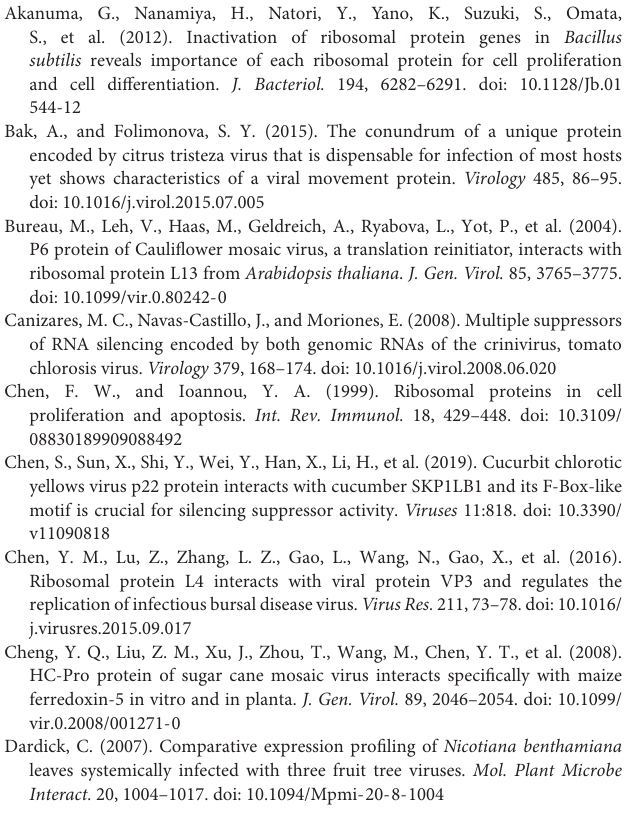
Supplementary Figure 1 | Alignment of amino acid sequences of CsRPS21 from different cucurbit plants. Supplementary Figure 2 | YFP fluorescence was not detected in the combination of P22-nYFP + cYFP and nYFP + CsRPS21-cYFP. Bar scale represents 20 µ m. Supplementary Figure 3 | (A) Colocalization of YFP-CsRPS21 and P22-RFP in N. benthamiana . Confocal images were taken at 2 dpi. Bar represents 20 µ m. (B) Free YFP was expressed as a control. Bar scale represents 20 µ m. Supplementary Figure 4 | YFP fluorescence was not detected in the combination of P22-nYFP + CsRPS21 1 − 90 -cYFP, P22-nYFP + cYFP,